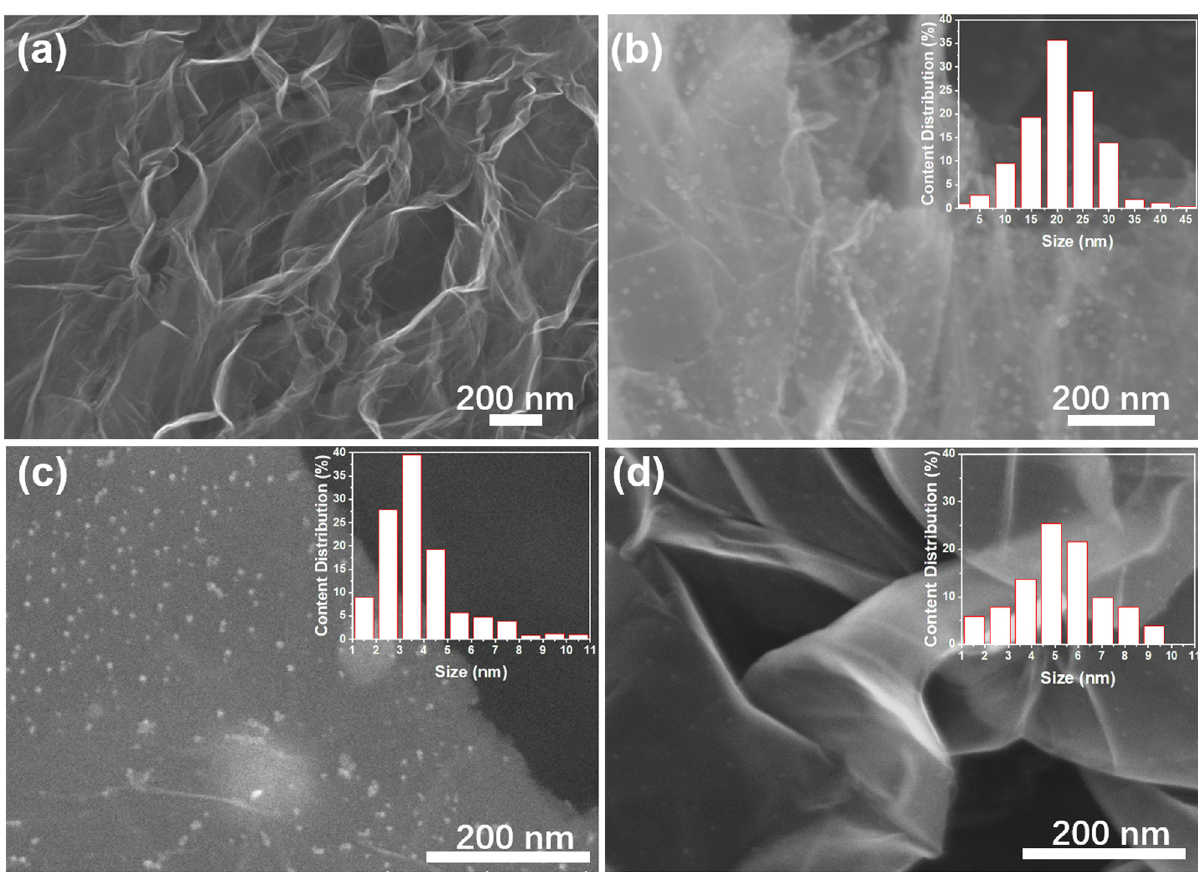
Figure 2: SEM images of ( a ) RGO, ( b ) FGN - 6, ( c ) FGN - 7, and ( d ) FGN -